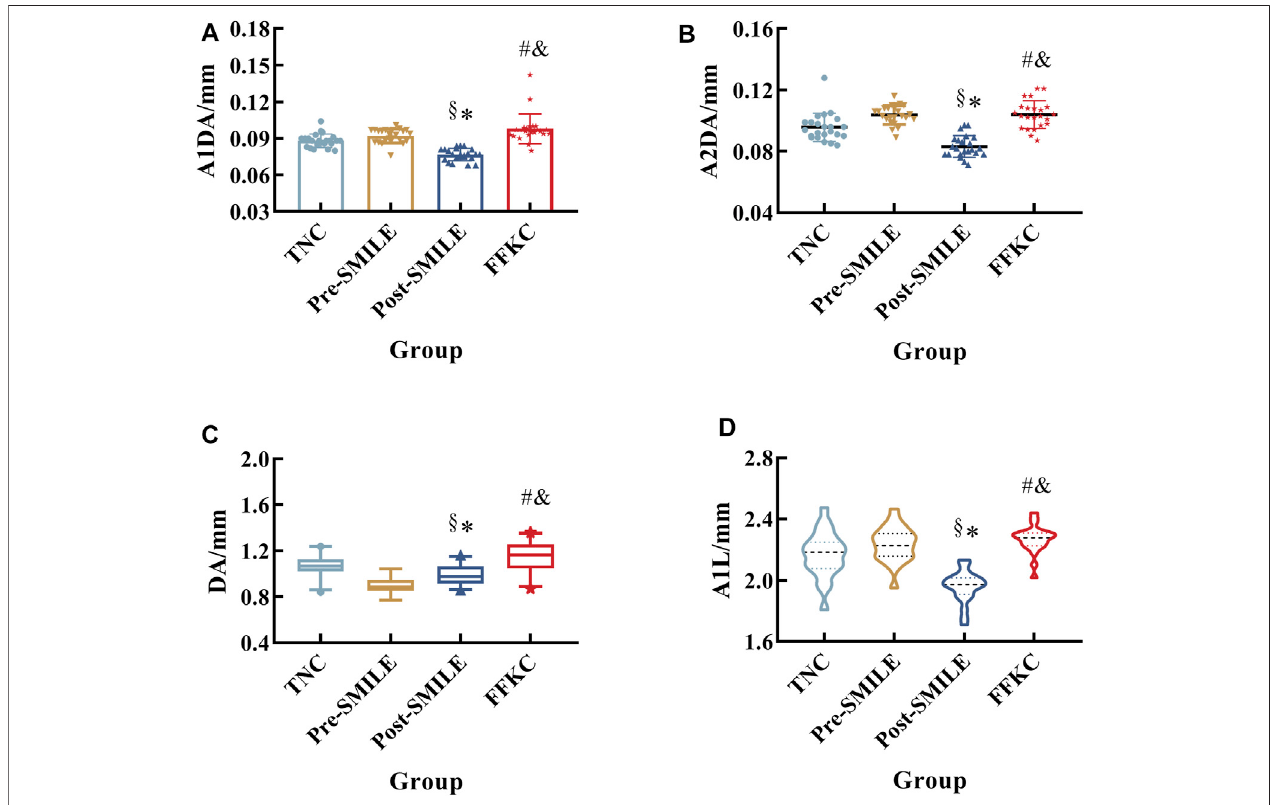
FIGURE3| DifferencesamongthethreegroupswithrespecttoA1DA (A) ,A2DA (B) ,DA (C) ,andA1L (D) .(*, # , & ,and § representstatisticallysigni fi cantdifferences between TNC and Post-SMILE, TNC and FFKC, Post-SMILE and FFKC, and Pre- and Post-SMILE,